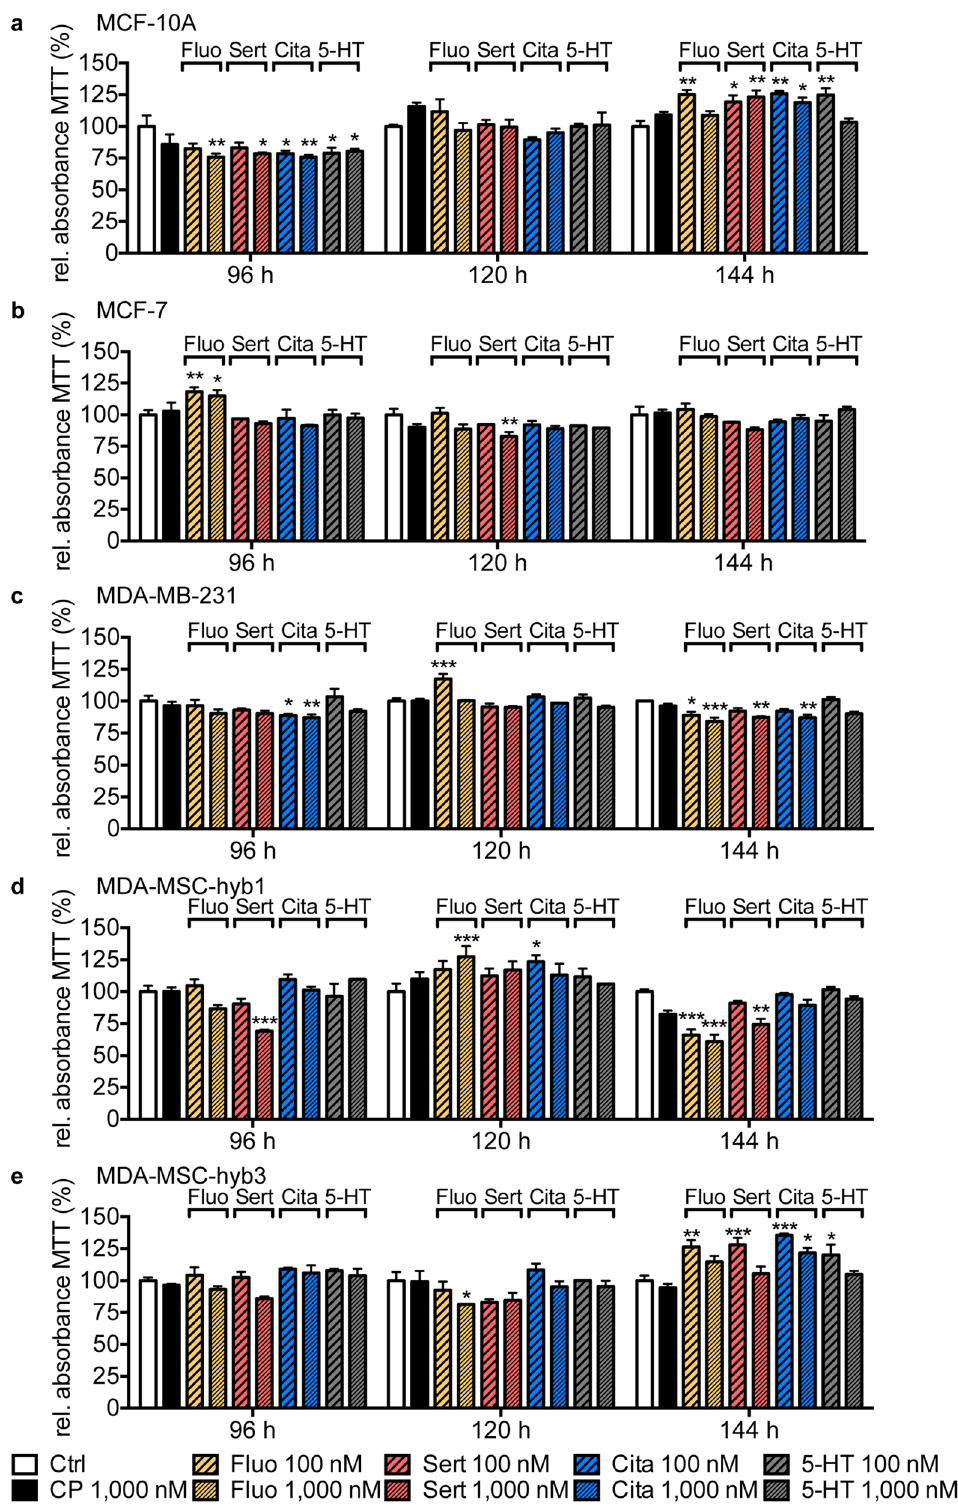
Figure 4. Effect of low-dose, long-term SSRI treatment or 5-HT exposure on breast cancer cell lines measured by MTT assay. Bar graphs depict relative absorbance of MTT assay of MCF-10A ( a ), MCF-7 ( b ), MDA-MB-231 ( c ), MDA-MSC-hyb1 ( d ) and MDA-MSC-hyb3 ( e ) cells in response to treatment with 100 nM or 1000 nM fluoxetine (Fluo; yellow), sertraline (Sert; red), citalopram (Cita; blue) or 5-HT (grey) for indicated time periods (96 h to 144 h) compared to DMSO-treated control cells (Ctrl; white) and cells receiving carboplatin (CP; 1000 nM; black). Data are depicted as mean ± SEM and summarize n = 3 experiments. P -values were determined by two-way ANOVA followed by Dunnett’s multiple comparison test; *** P < 0.001; ** P < 0.01; * P < 0.05 versus corresponding